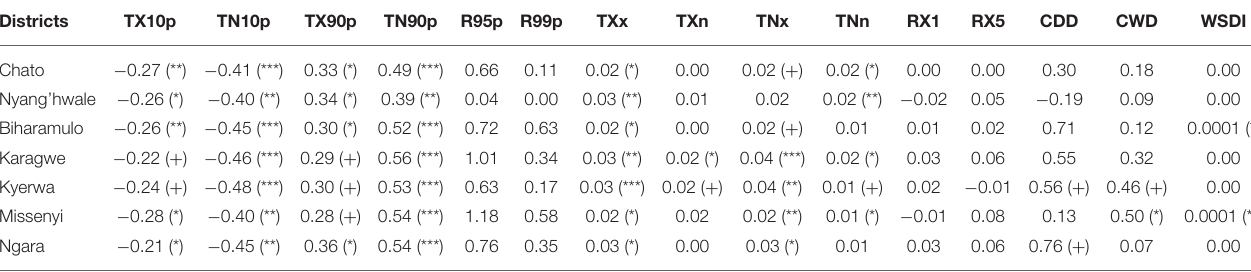
TABLE 5 | Climate extreme indices during the historical climate condition (1971–2000).